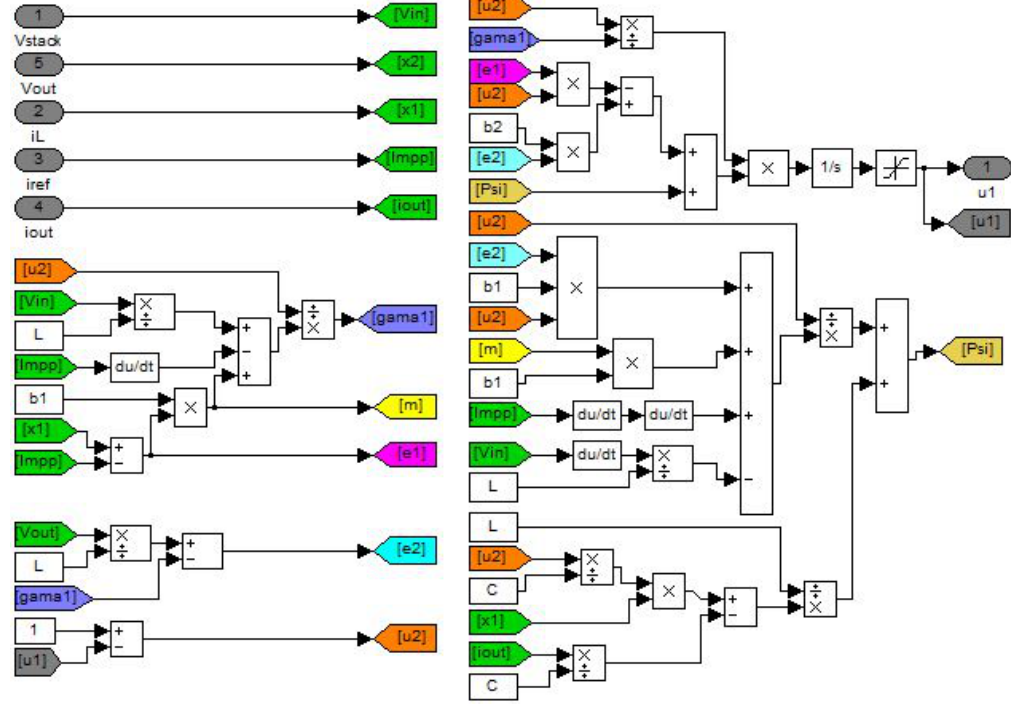
Figure 12. Synoptic diagram of the backstepping algorithm.